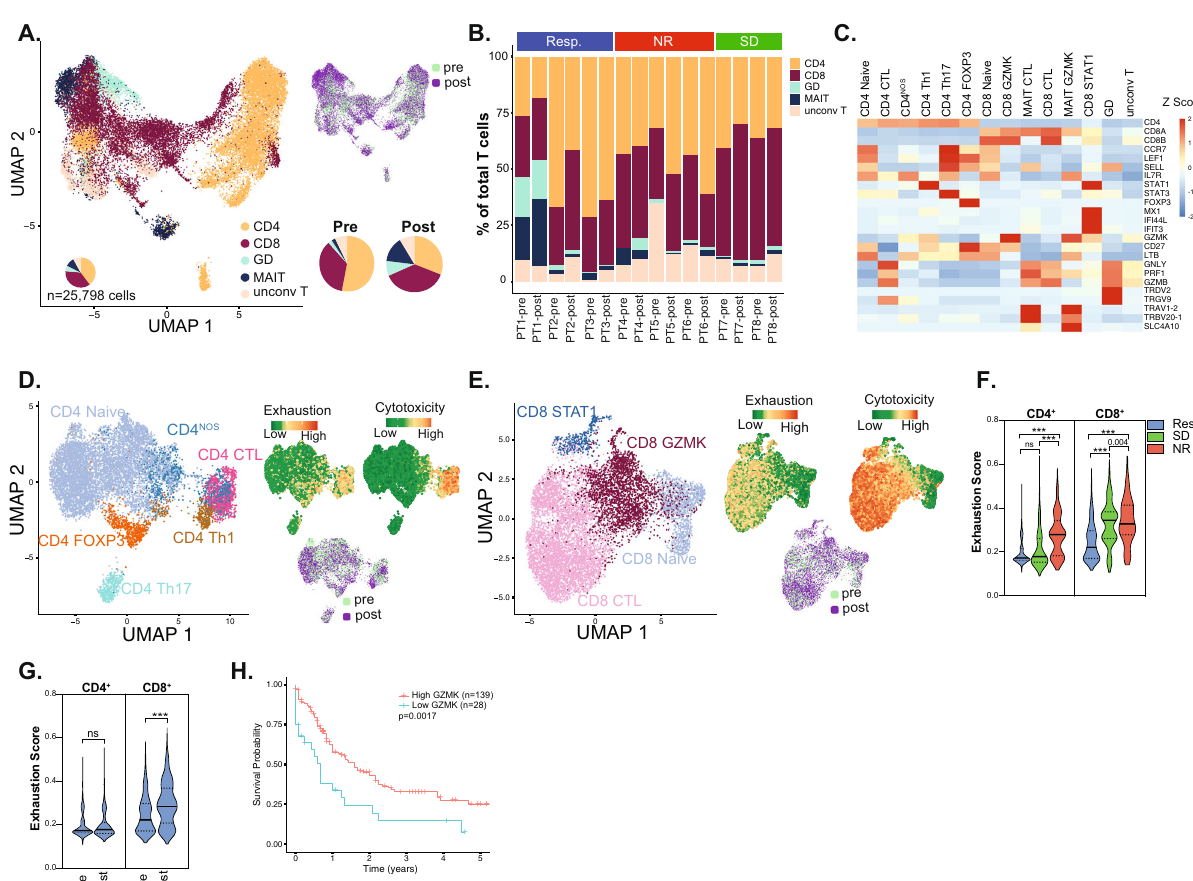
Fig. 3 Characterization of T-cell subsets. A UMAP of T cell subsets. B Distribution of T cell subsets prior to and following treatment. C Heatmap of canonical marker expression of identi fi ed T cell subsets. UMAP of the different D CD4 + and E CD8 + phenotypes with exhaustion and cytotoxicity scores projected onto the UMAP. F Mann – Whitney test for exhaustion scores of CD4 + and CD8 + T lymphocytes of different response groups prior to treatment. G Mann – Whitney test for exhaustion scores of CD4 + and CD8 + T lymphocytes at pre and post treatment in responders. H Overall survival of AML patients in TCGA cohort by GZMK